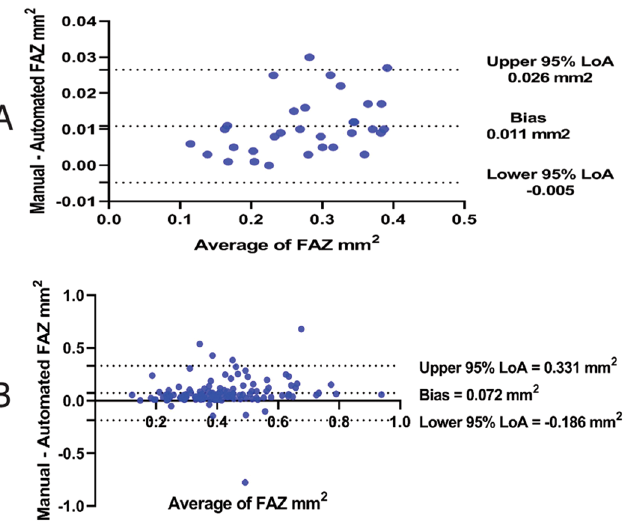
Figure 3. Bland–Altman plot shows ( A ) good agreement between manual and automated Foveal avascular zone (FAZ) area measurement in normal eyes, however, ( B ) poor agreement is evident in eyes with diabetic